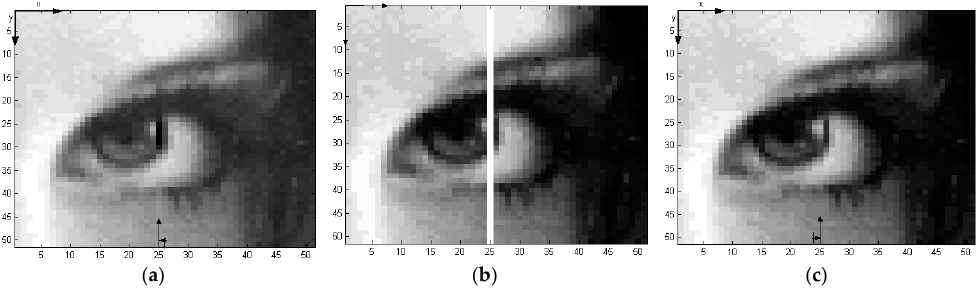
Figure 16. Warping by using local TPS algorithm: ( a ) Torn image; ( b ) Reconstruction by using available information in the left part; ( c ) Reconstruction by using available information in the right part.